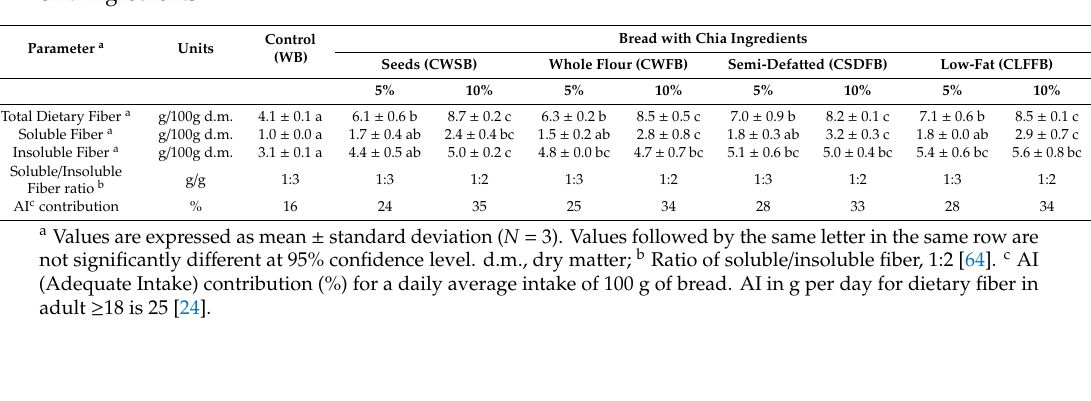
Table 4. Dietary fiber content and contribution to adequate intake in bread formulated with chia